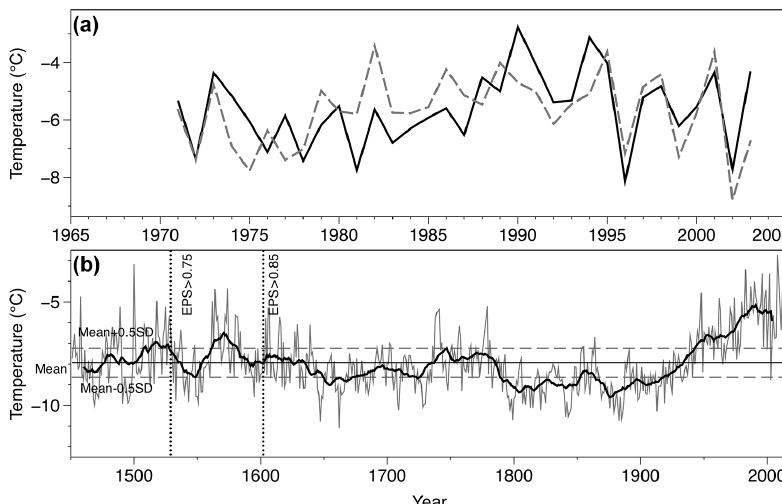
Figure 5. (a) Actual (black line) and reconstructed (dash line) August–December minimum temperature for the common period of 1971– 2003; (b) reconstruction of August–December minimum temperature (VUSr) for the southern part of Sikhote-Alin for the last 563 years. The smoothed line indicates the 21-year moving average.